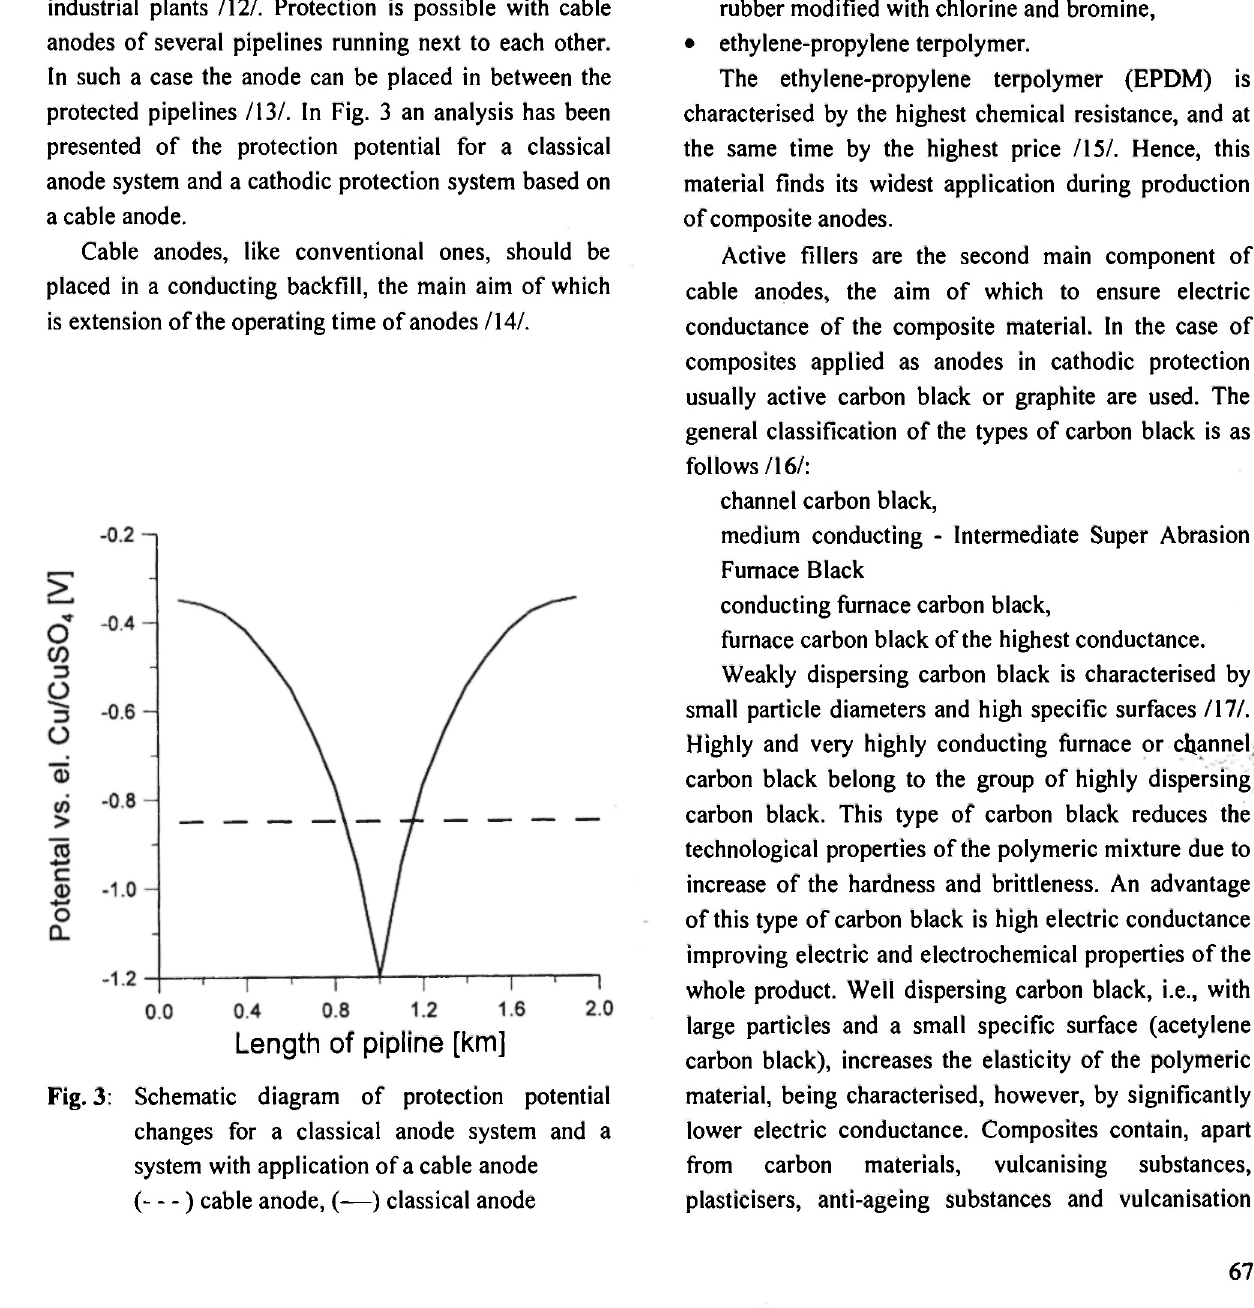
Fig. 3: Schematic diagram of protection